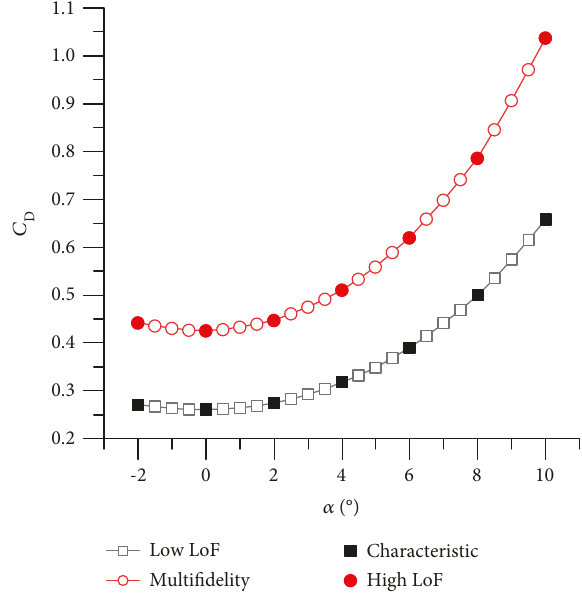
Figure 3: Multi fi delity data using the multi fi delity